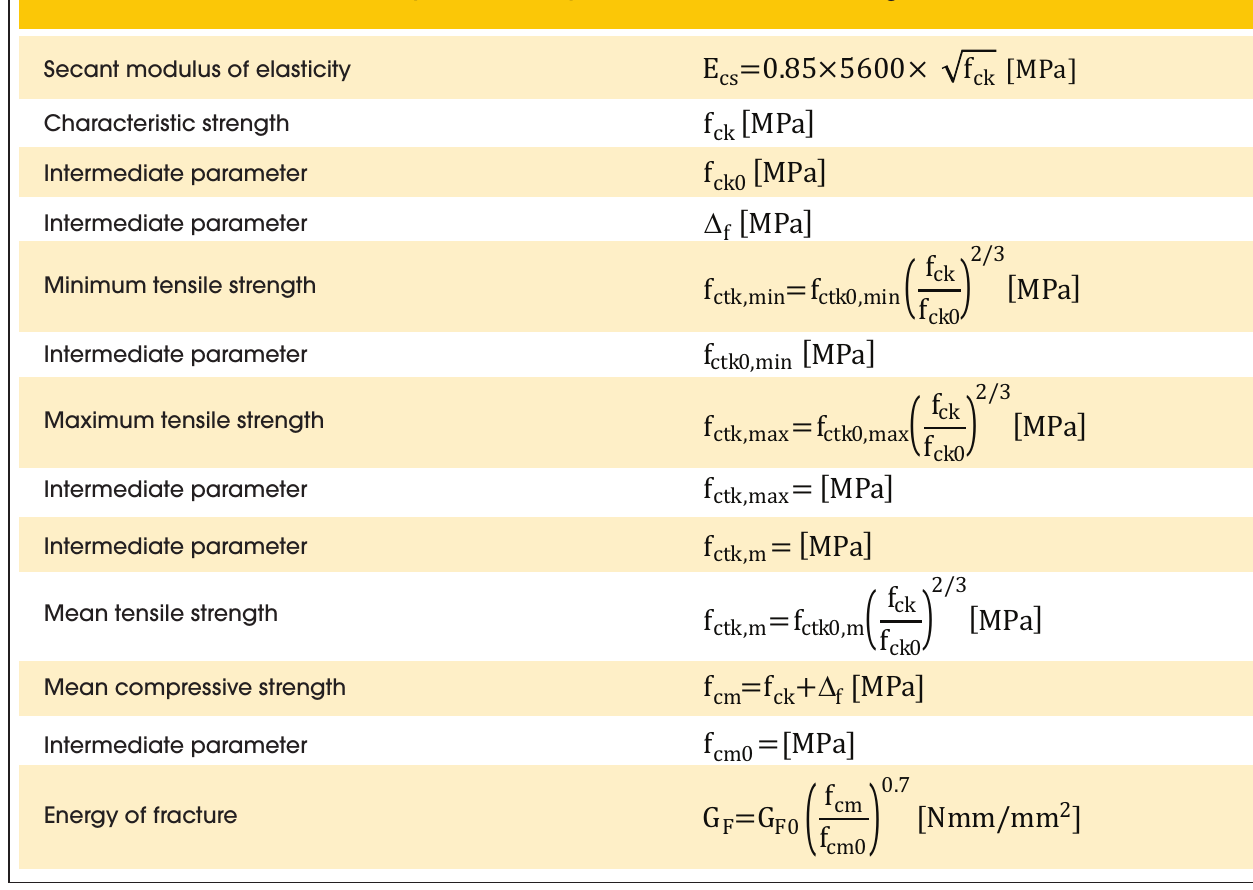
Table 1 – Properties and equations for concrete cracking